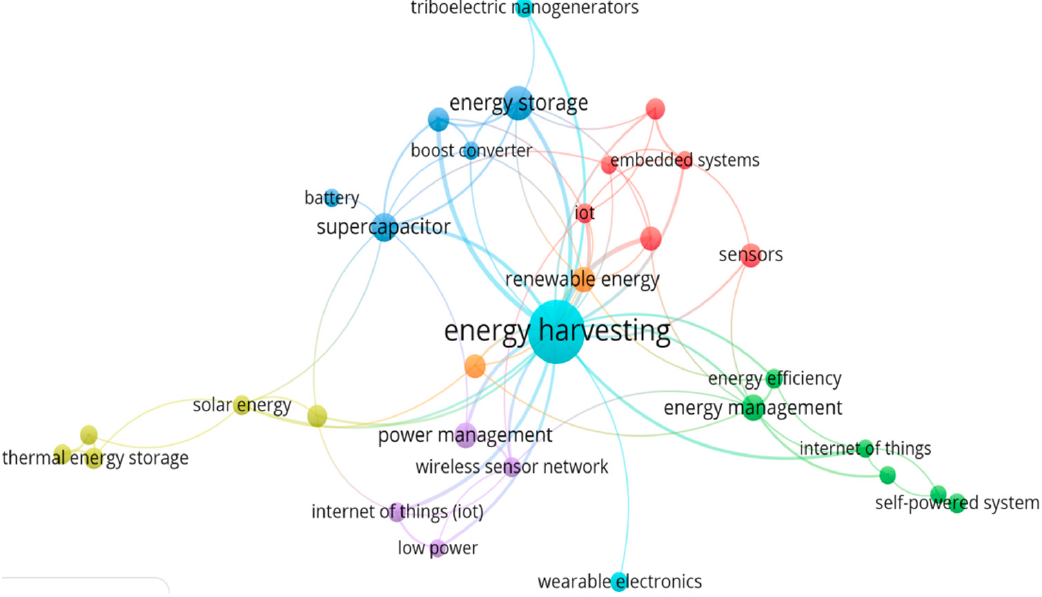
Figure 4. Finalized manuscript from the Scopus database based on the Co-occurrence keywords.